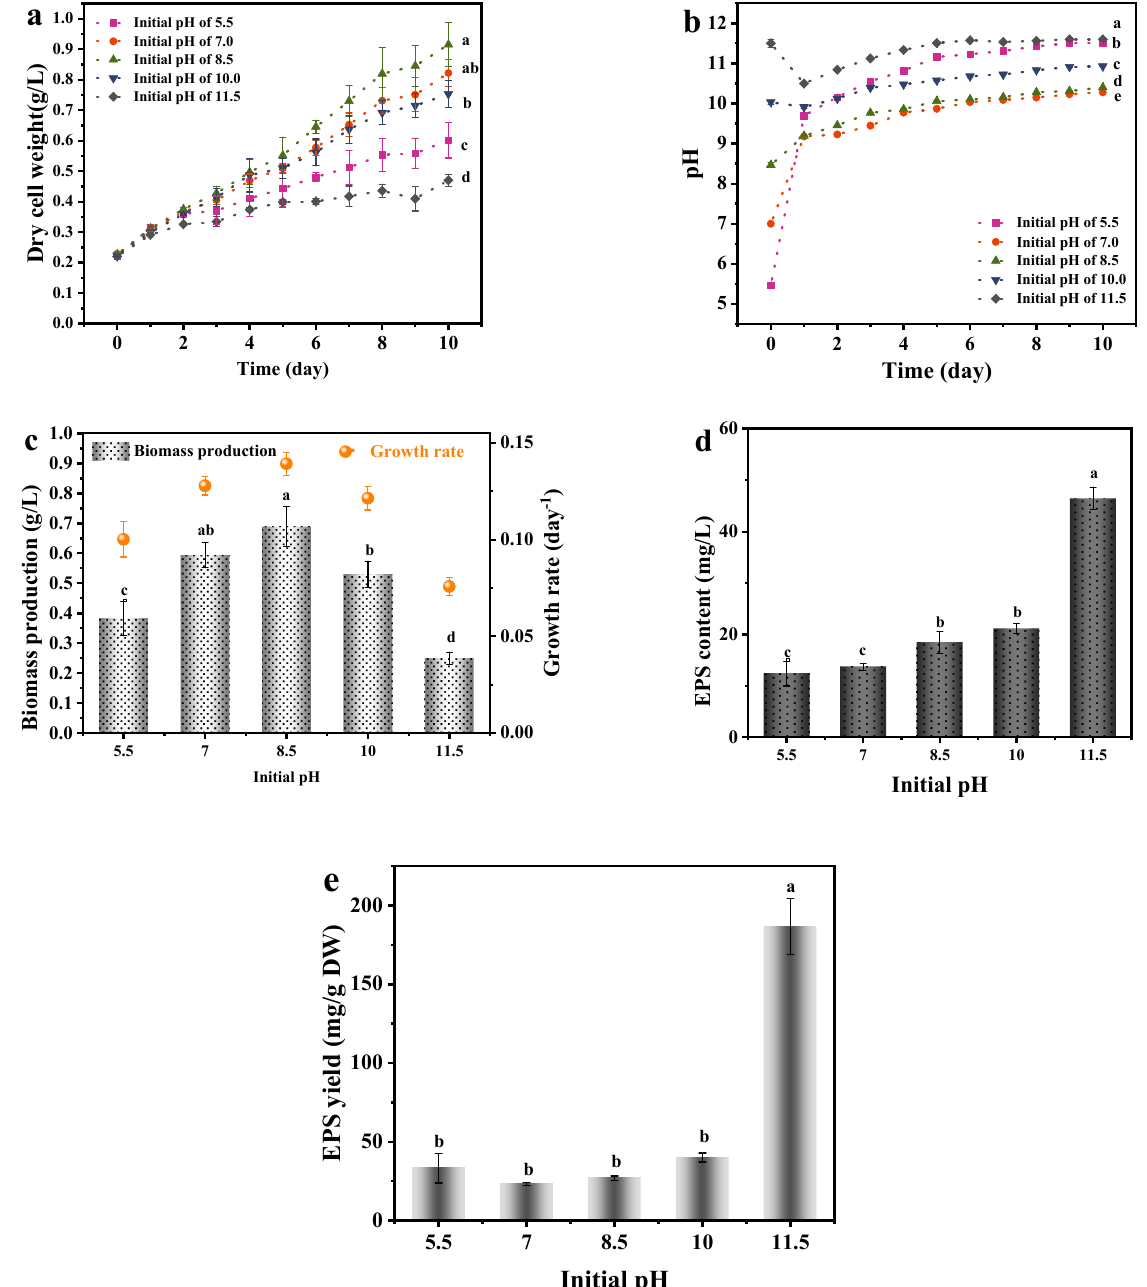
Figure 3. The effects of initial pH medium on the growth and EPS secretion of A. platensis : ( a ) Growth curves; ( b ) pH value; ( c ) Biomass production and growth rate; ( d ) EPS content; ( e ) EPS yield; DW: dry weight; a–e: Different letters above the bars indicated a significant difference among the groups. Points showed average of three independent measurements; vertical bars indicated the standard deviation. ( p < 0.01, n = 3).